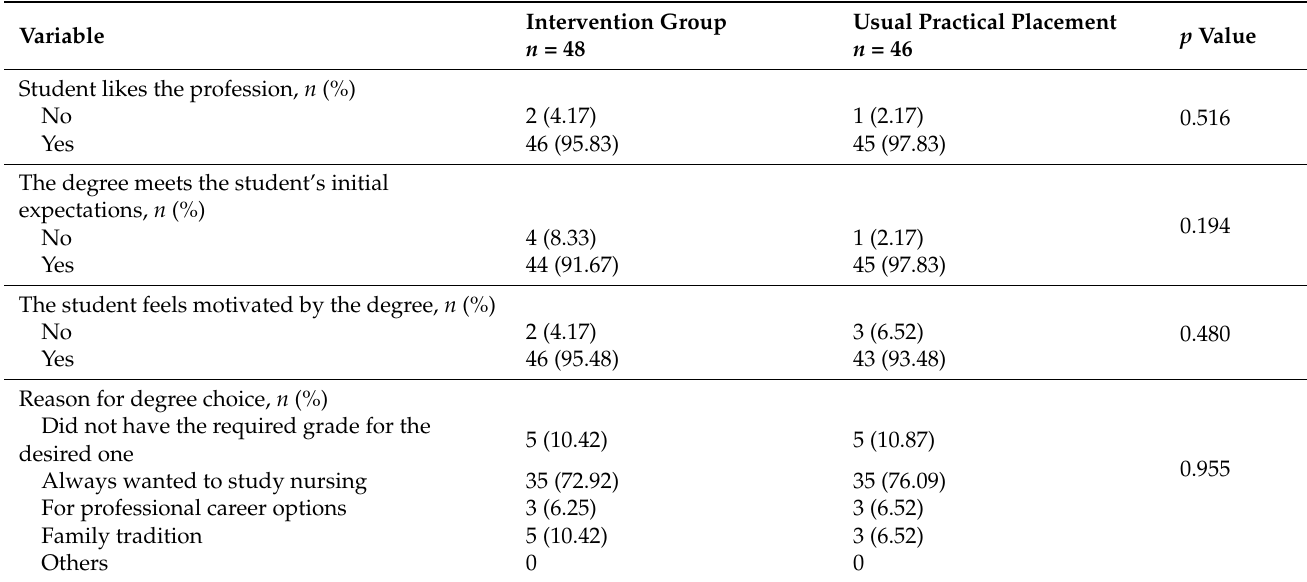
Table 2. Association of variables related to motivation and career development.